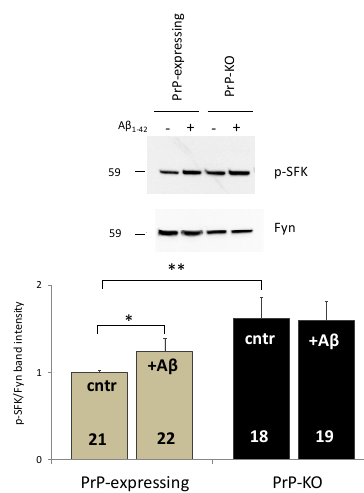
Figure 1. Soluble A β 1–42 oligomers abrogate the PrP-dependent control over Fyn in PrP-expressing primary cortical neurons. Both the representative western blot (WB) obtained after probing PrP-expressing and PrP-KO cortical neurons (treated (+), or not ( − ), with A β 1–42 oligomers) with antibody to active (auto-phosphorylated, p) SFK or total Fyn (upper panel), and the densitometric analysis of the pSFK immuno-reactive bands normalized to the corresponding signal of total Fyn (lower panel), show that A β addition significantly relieves the restriction on Fyn activation observed in untreated PrP-expressing controls relative to PrP-KO counterparts (cntr, grey and black bars, respectively). Conversely, no impact of A β was observed in PrP-KO neurons (see text for the explanation of the higher Fyn activation in untreated PrP-KO neurons). After seven days in culture, primary cortical neurons (isolated from PrP-expressing and PrP-KO mice lines Tg46 and F10, respectively [57] (Authorization n. 13/2012), and cultured as previously described [46]), were incubated (1 h, 37 °C), or not, with A β 1–42 oligomers (5 µM, prepared and oligomerized as in [45]), and then lyzed using an ice-cold buffer containing glycerol (10% ( w / v )), SDS (2% ( w / v )), Tris/HCl (62.5 mM, pH 6.8), urea (1.8 M), Na 3 VO 4 (5 mM), and cocktails of protease and phosphatase inhibitors (Roche). Total protein quantification, WB and densitometric analyses were accomplished as described elsewhere [45]. Here and after, values are expressed as mean ± SEM, and the number of replicates (i.e., different replicates from at least four primary cortical cultures prepared on different days) is indicated inside each bar